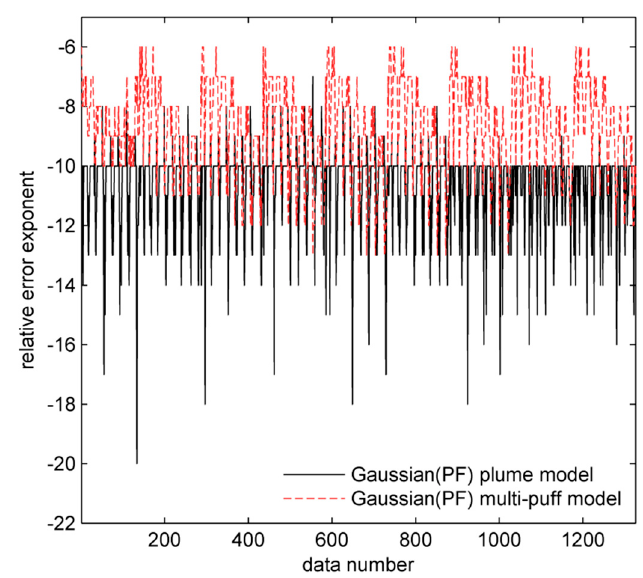
Figure 5. Relative error exponents of concentrations.